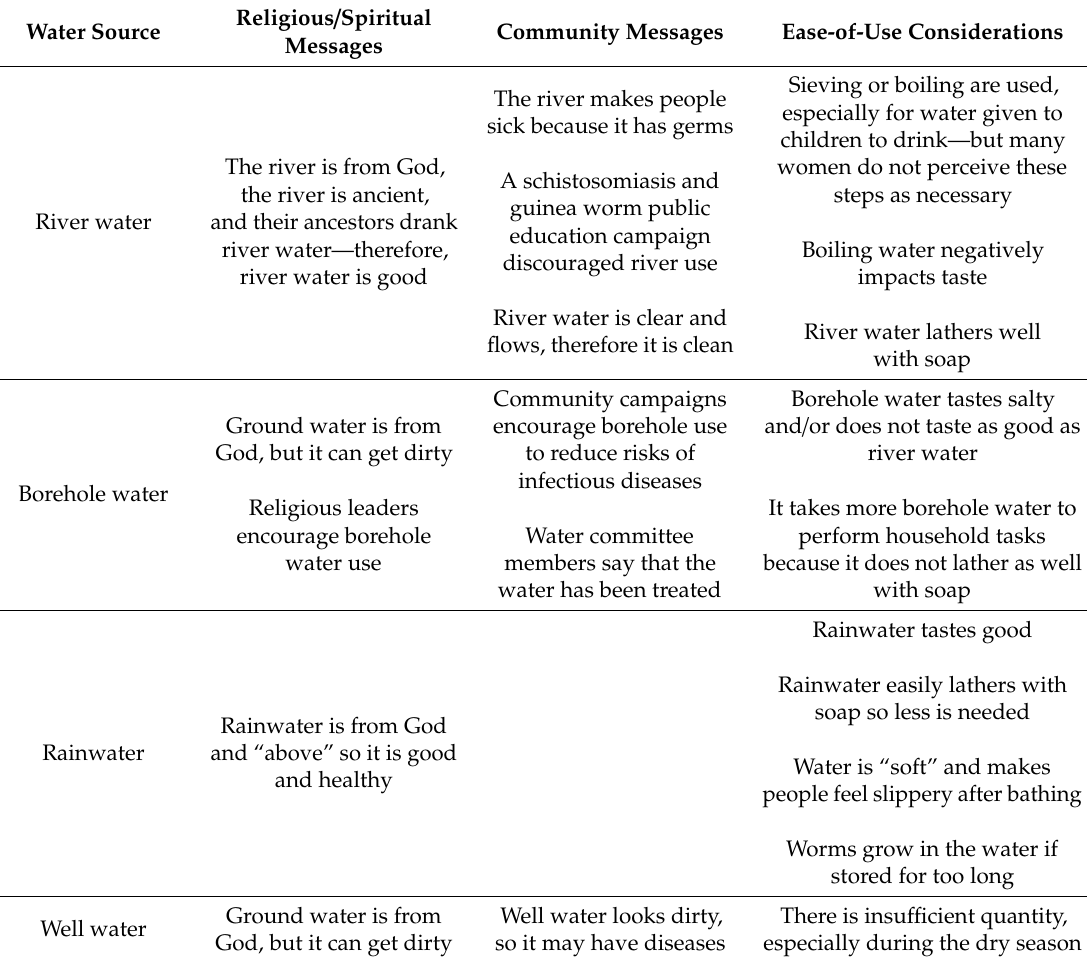
Table 2. Influence of religious / spiritual messages, community messages, and ease-of-use considerations on perceptions of water